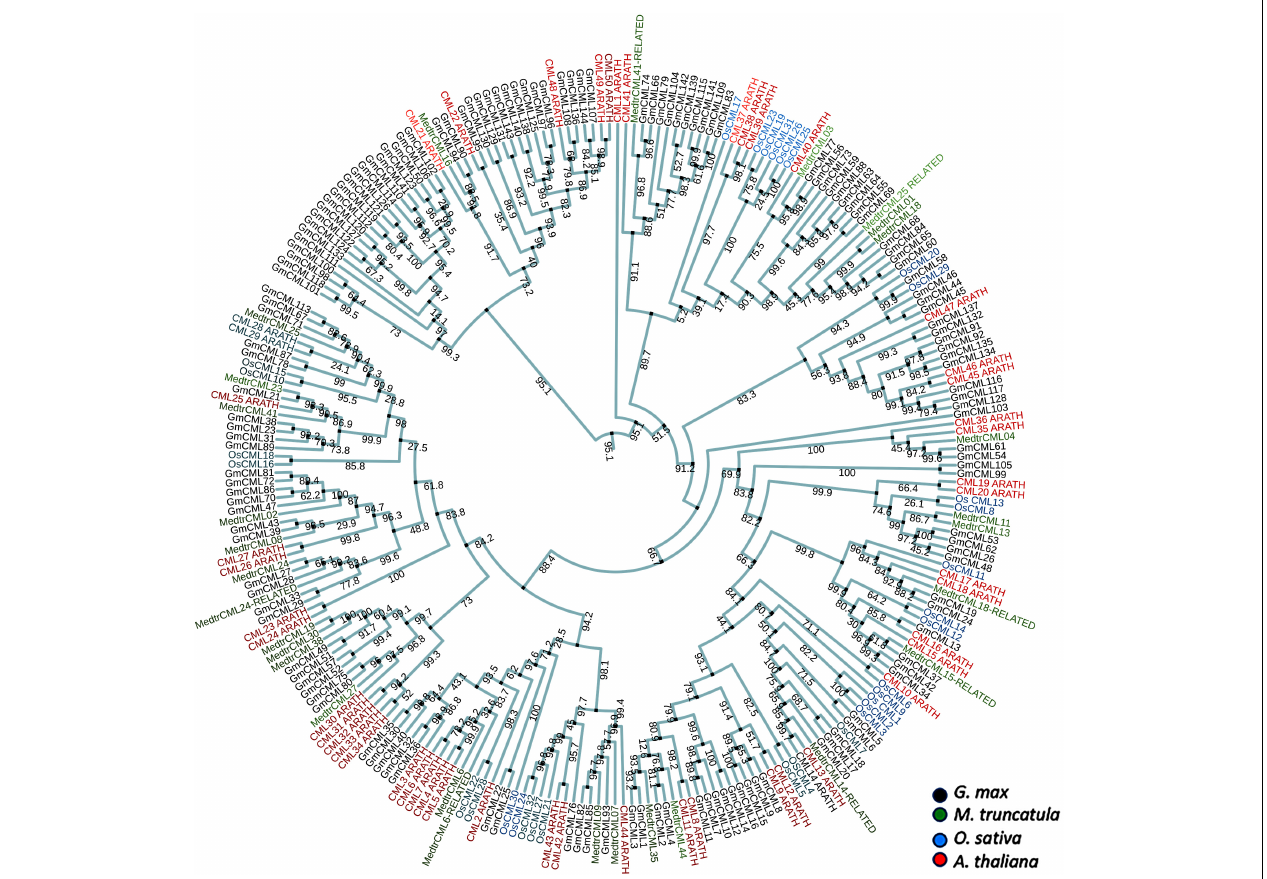
FIGURE 1 | The phylogenetic analysis of CMLs of Glycine max, Medicago truncatula, Oryza sativa, and Arabidopsis thaliana. The alignment for phylogenetic tree was performed with Clustal Omega using full-length protein sequences. The phylogenetic tree was constructed using iTOL. All the Glycine max CMLs (GmCMLs) are presented with black , Medicago truncatula CMLs are presented with green , Oryza sativa CMLs are presented with blue, and Arabidopsis thaliana CMLs are presented with red. The bootstrap values are provided in the mid of the nodes.